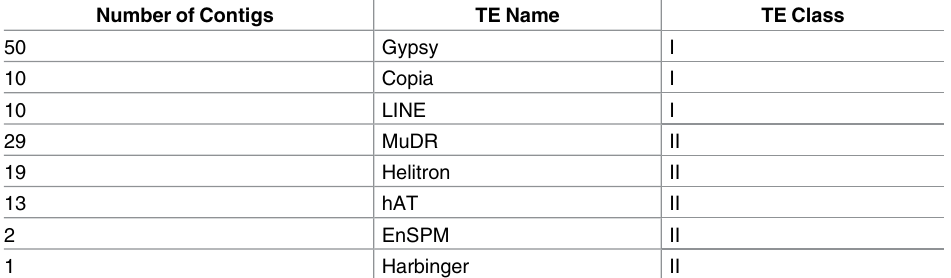
Table 4. Transcriptionally active transposable elements in C . arabica transcriptome.